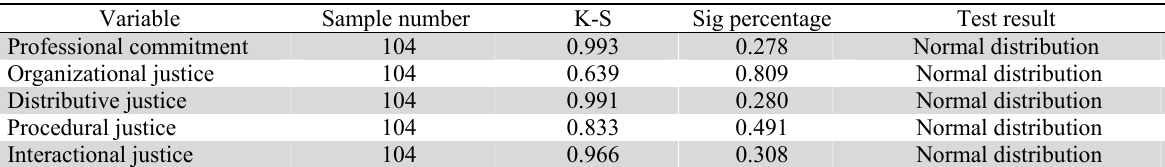
The results of Komolouve-Smirenove